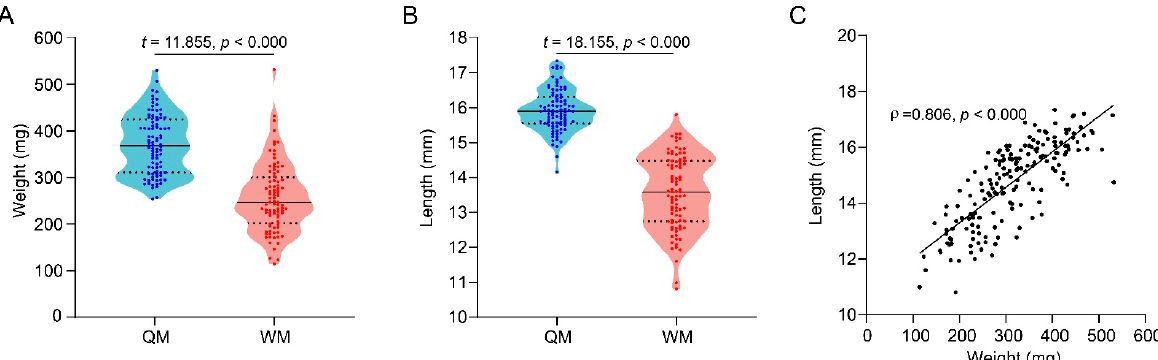
Figure 1. Comparison of body weight and forewing length of the QMs and the WMs. ( A ) Body weight of the QMs and the WMs ( n = 90 and 88, respectively); ( B ) forewing length of the QMs and the WMs ( n = 90 and 88, respectively); ( C ) correlation between weight and forewing length of all the experimental the QMs and the WMs ( n = 178). QMs and WMs represent the males produced by queens in queenright colonies and by workers from queenless micro-colonies, respectively. A t -test was used to analyze whether significant differences existed in weight and forewing length between the QMs and the WMs. Spearman rank correlation test was used to analyze the correlation between weight and forewing length of male bees. The scatter plots represented the data values.